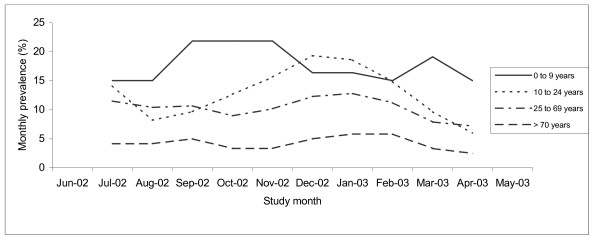
Three-month moving average of monthly prevalence of acute gastrointestinal illness by study month and age group (in years), in the province of British Columbia, Canada.